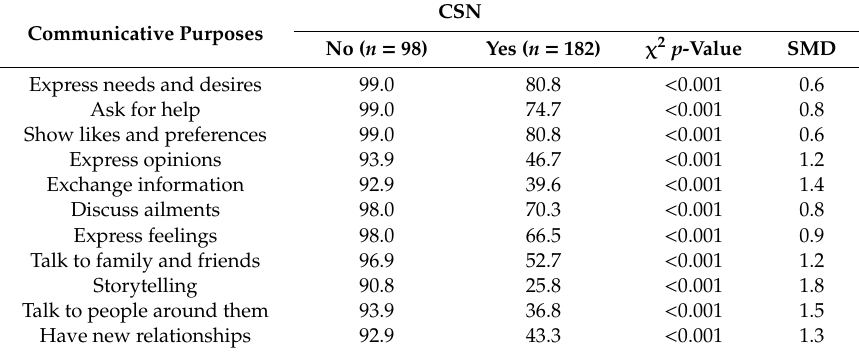
Table 3. Percentage of participants who are able to communicate for di ff erent purposes as a function of communication support